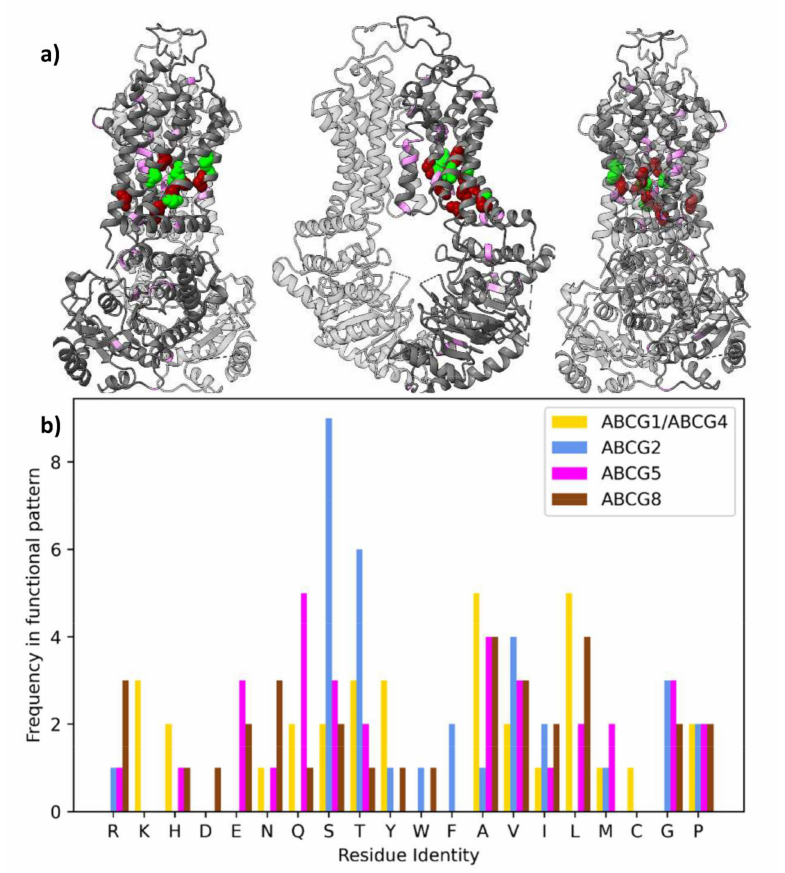
Figure 5. Comparison of the polar relay with functionally divergent residues. ( a ) Distribution on structure of ABCG2. Residues found in the polar relay are shown as spheres. Those with the conservation pattern (ABCG1, ABCG4), (ABCG2), (ABCG5), (ABCG8) are coloured green. Others are coloured red. Residues outside the polar relay with the conservation pattern above are coloured violet within the cartoon representation. ( b ) Identity of residues with conservation pattern (ABCG1, ABCG4), (ABCG2), (ABCG5), (ABCG8). Bars are coloured by protein, and their height represents the number of that residue found in the 33 positions with the above conservation pattern for that